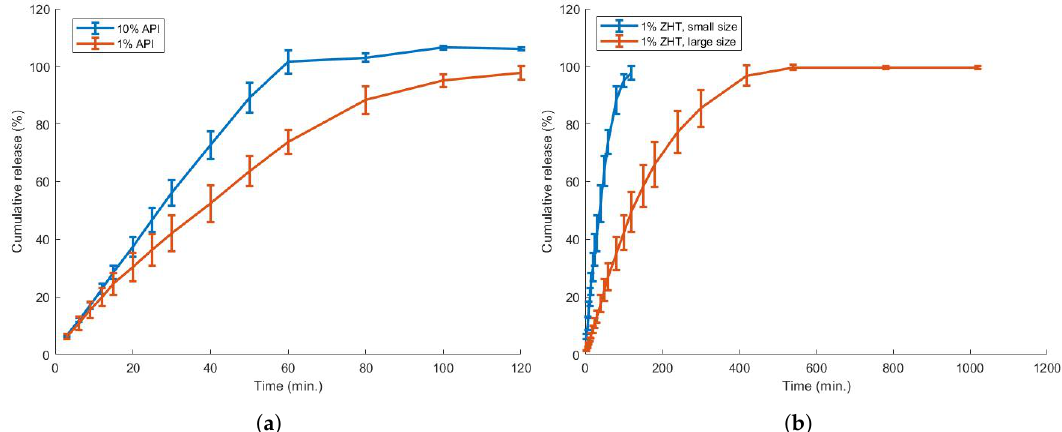
Figure 11. The effect of ZHT drug load ( a ) and caplet size ( b ) on the in vitro dissolution behaviour. Decreased drug load resulted in a decreased in vitro dissolution rate, while enlargement of the caplet greatly affected the dissolution profile. Table 7. Weight and dimension analysis of modified caplets in order to achieve immediate release dosage forms. Caplets (11.0 × 5.5 × 4.4 mm) are modified by either channel incorporation in